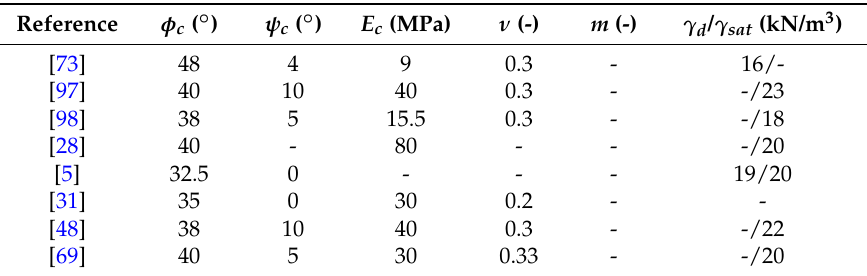
Table 4. Parameters used to model encased stone columns in numerical